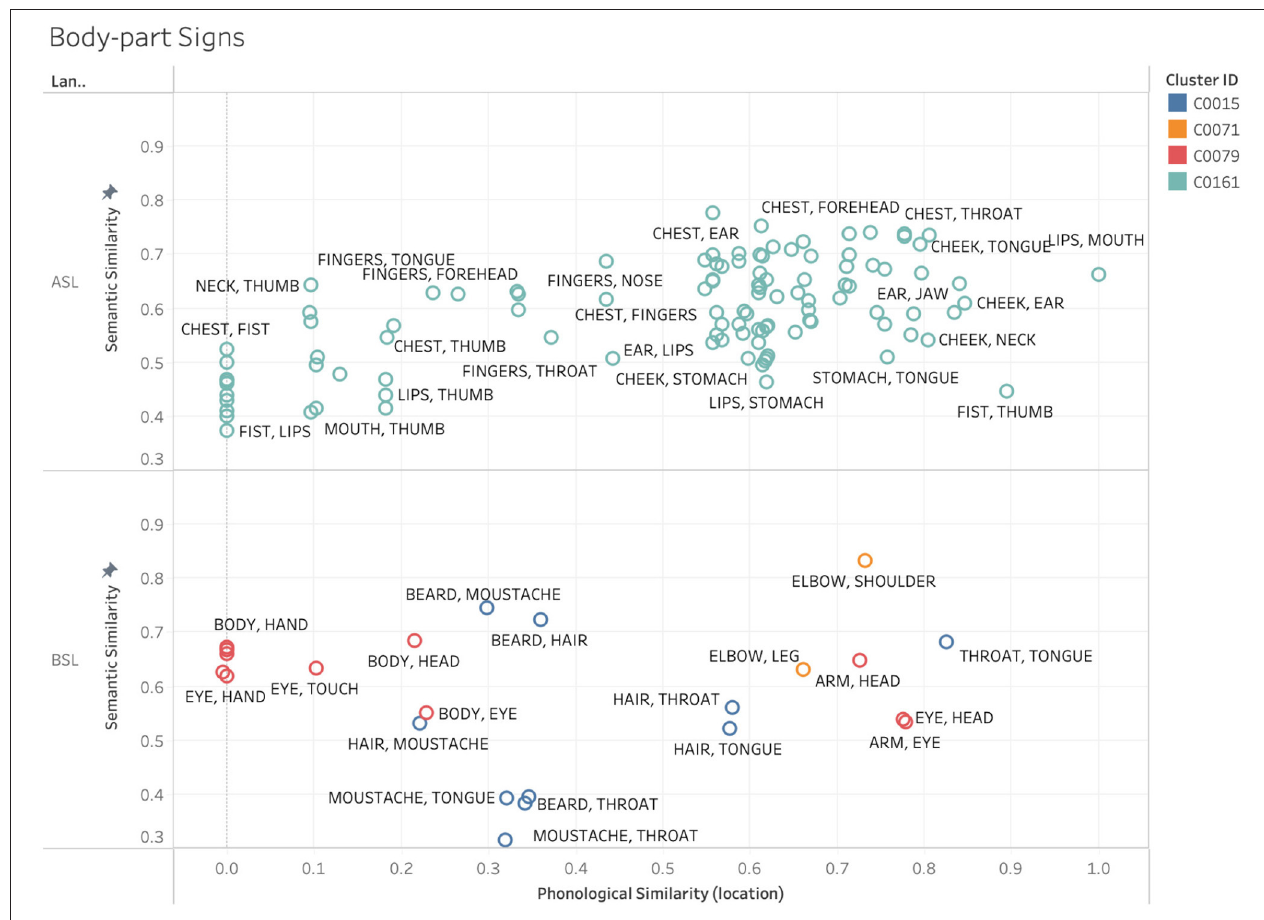
FIGURE 8 | Example sign pairs relating to parts of the body in ASL and